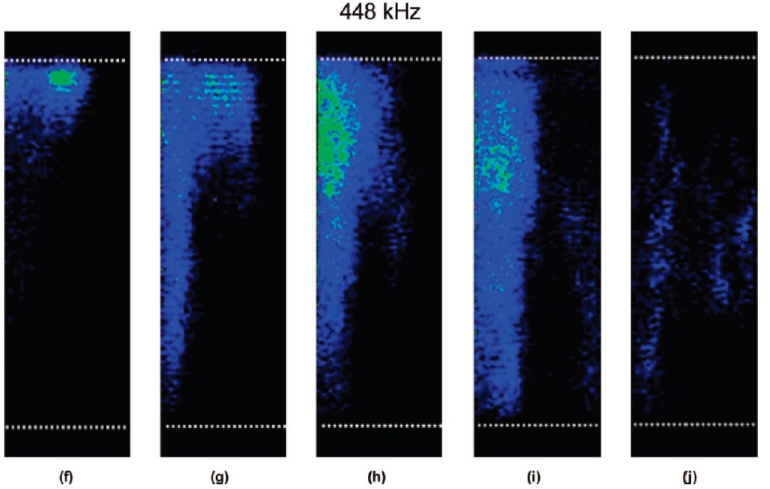
Figure 25. Images showing the effect of increasing pulse-off time on the MBSL structure generated in saturated water at a frequency of 448 kHz and at a power of 1.1 W/cm 2 : ( f ) 1.5, ( g ) 10, ( h ) 40, ( i ) 110, and ( j ) 135 ms [59]. The pulse-on time was fixed at 5 ms. The white dotted lines above and below the MBSL structure denotes the liquid surface and the transducer position, respectively. The center axis of the vessel is located on the left side of the images. Copyright 2008, with the permission from American Chemical Society.